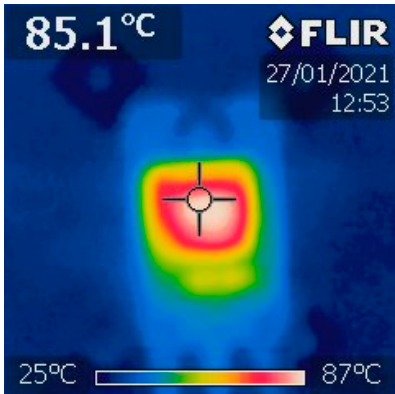
Figure 7. An exemplary thermal image of NGB8207BN transistors soldered in a batch oven.